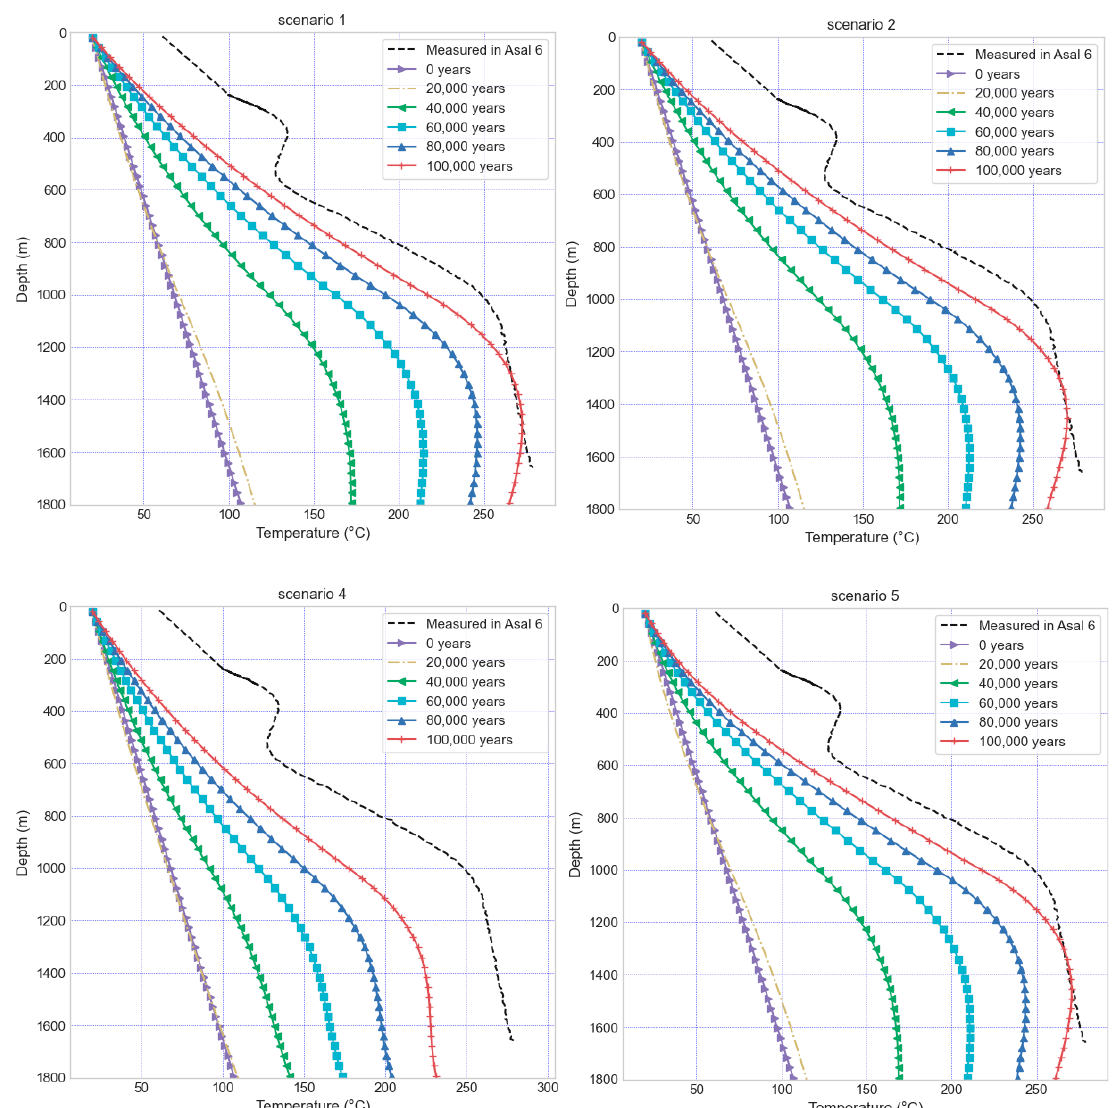
Figure 8. Comparison between the observed and simulated temperatures at well Asal 6.